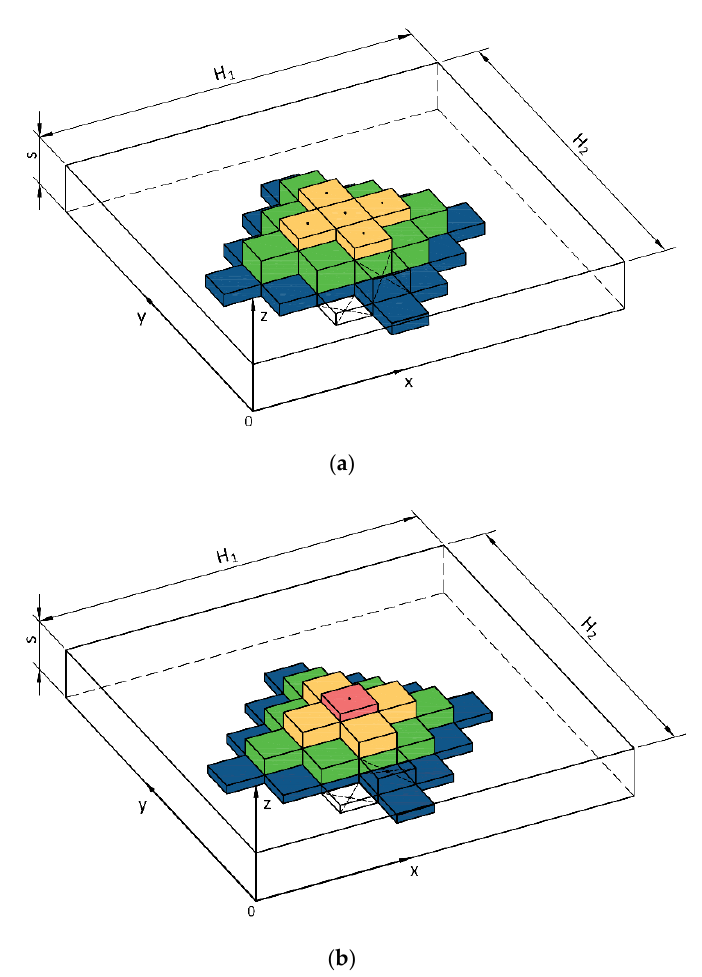
Figure 2. Dividing the plate into ( a ) three and ( b ) four control volumes layers on the slab thickness.